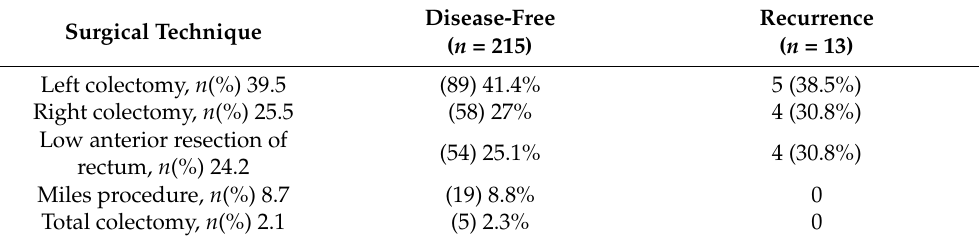
Table 2. Surgical techniques.